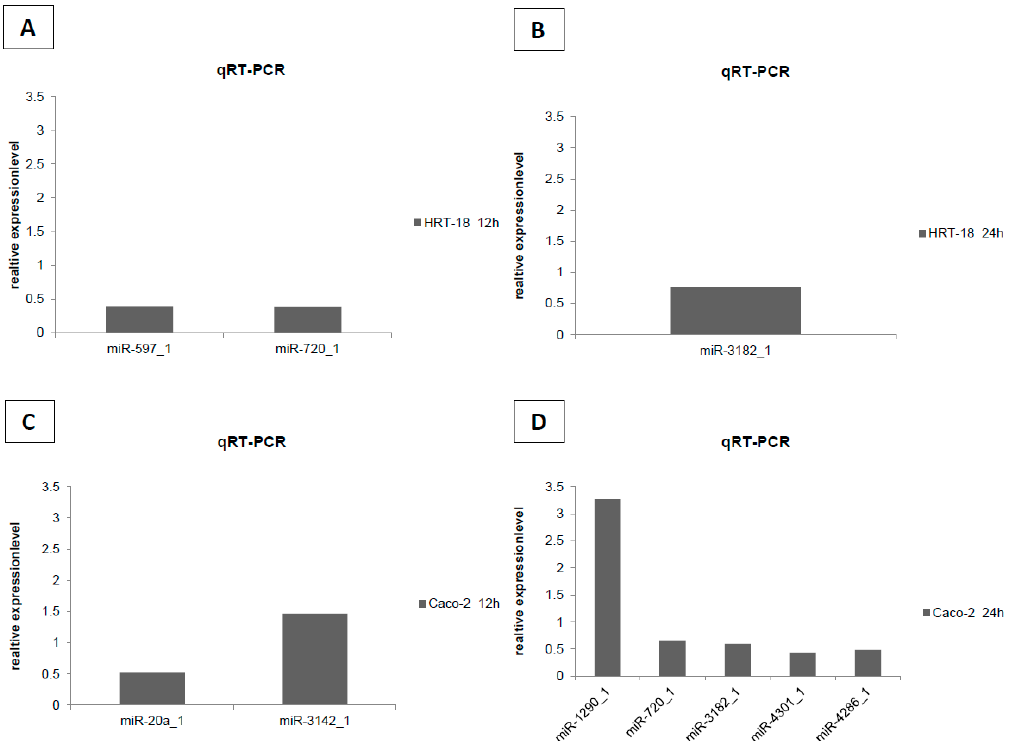
Figure 5. Quantitative RT-PCR (RT-qPCR) confirmation study of nine miRNAs. Except miR-767-3p, which was not detectable by RT-qPCR, we could confirm all other miRNAs detected by the microarray (miR-597, miR-720, miR-3182, miR-20a, miR-4301, miR-3142, miR-4286, miR-3142, miR-4286 and miR-1290). miRNA expressions normalized to SNORD68 are shown in relation to the untreated DMSO control. Representative examples of technical replicates are shown. ( A ) HRT-18 cell expression analysis after 12 h; ( B ) HRT-18 cell expression analysis after 24 h; ( C ) Caco-2 cell expression analysis after 12 h; and ( D ) Caco-2 cell expression analysis after 24 h.